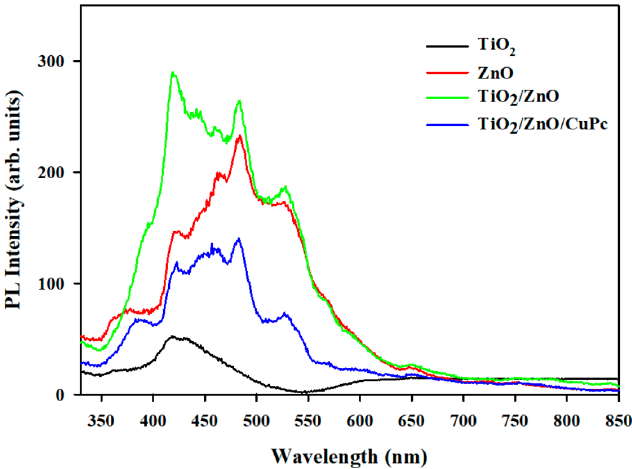
Figure 6. Photoluminescence plots of TiO 2 (black line), ZnO (red line), TiO 2 /ZnO (green line), and TiO 2 /ZnO/CuPc (blue